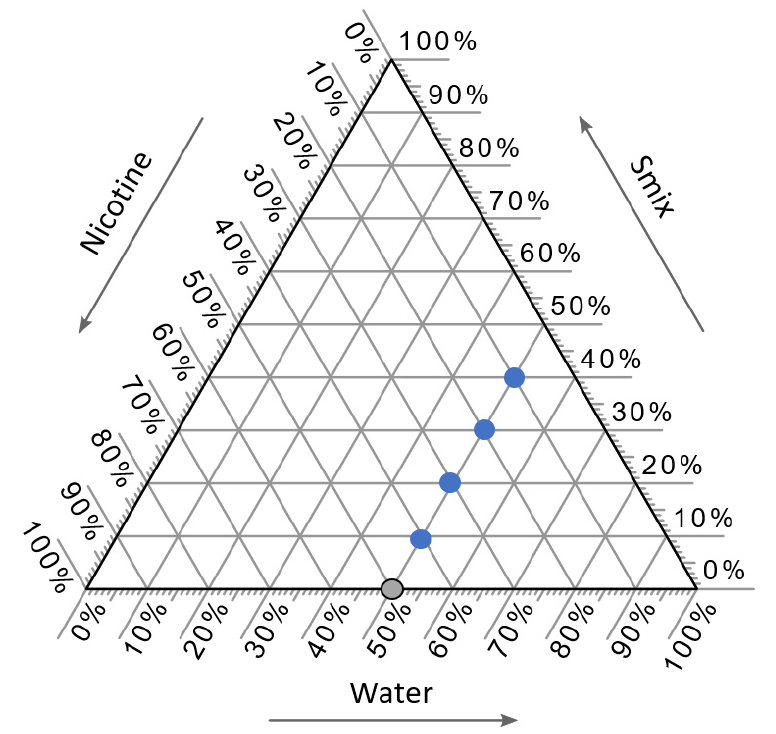
Figure 4. Selected components from pseudo-ternary phase diagrams of the NCT-ME, which were composed of NCT, Smix, and water. The blue circles represent the NCT-ME formulations, whereas a gray circle represents the NCT without ME. Table 5. Type and concentration (% w / w ) of the components used in each preparation of NCT-ME .